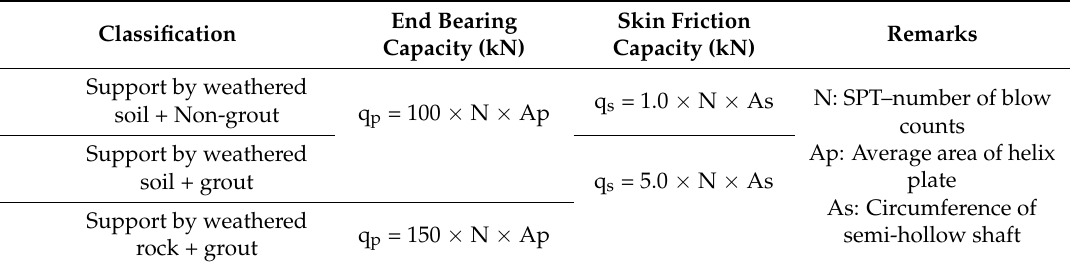
Table 10. Experimental equations for calculating the bearing capacity of the helical